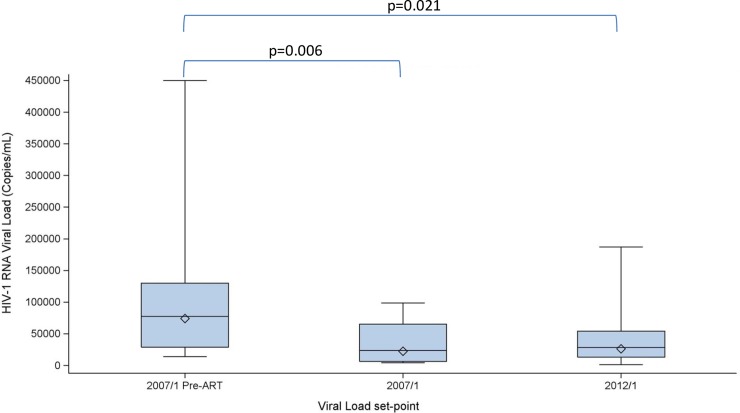
Viral load set-points in the per protocol population for participants with all three time points (n = 13).The box plots show the minimum, first quartile (Q1), median, third quartile (Q3) and maximum values for each set-point. Diamonds correspond to GM values. The maximum VL value for preART VL is 750 000 copies/mL. PreART GM VL set-point: 74048 copies/mL; 2007/1: 22475 copies/mL; 2012/1: 26279 copies/mL. The p-values are derived from a paired t-test on logged set-point values.